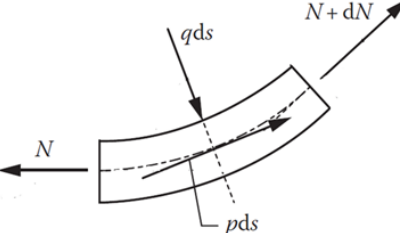
Figure 7: Rope element in equilibrium